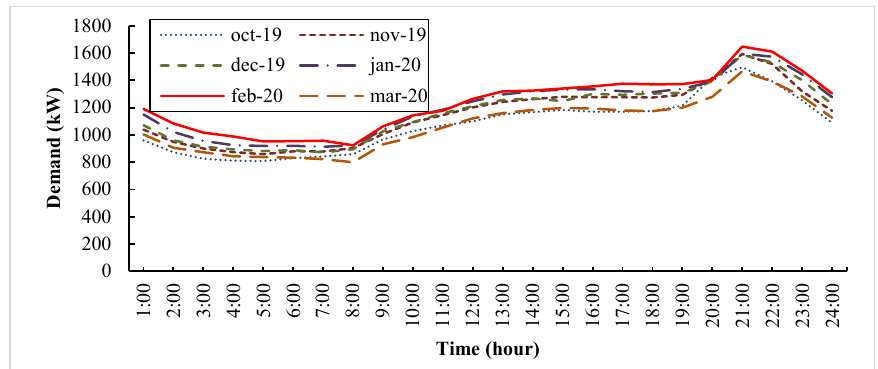
Figure 3. Average demand profile from April 2019 to September 2019.